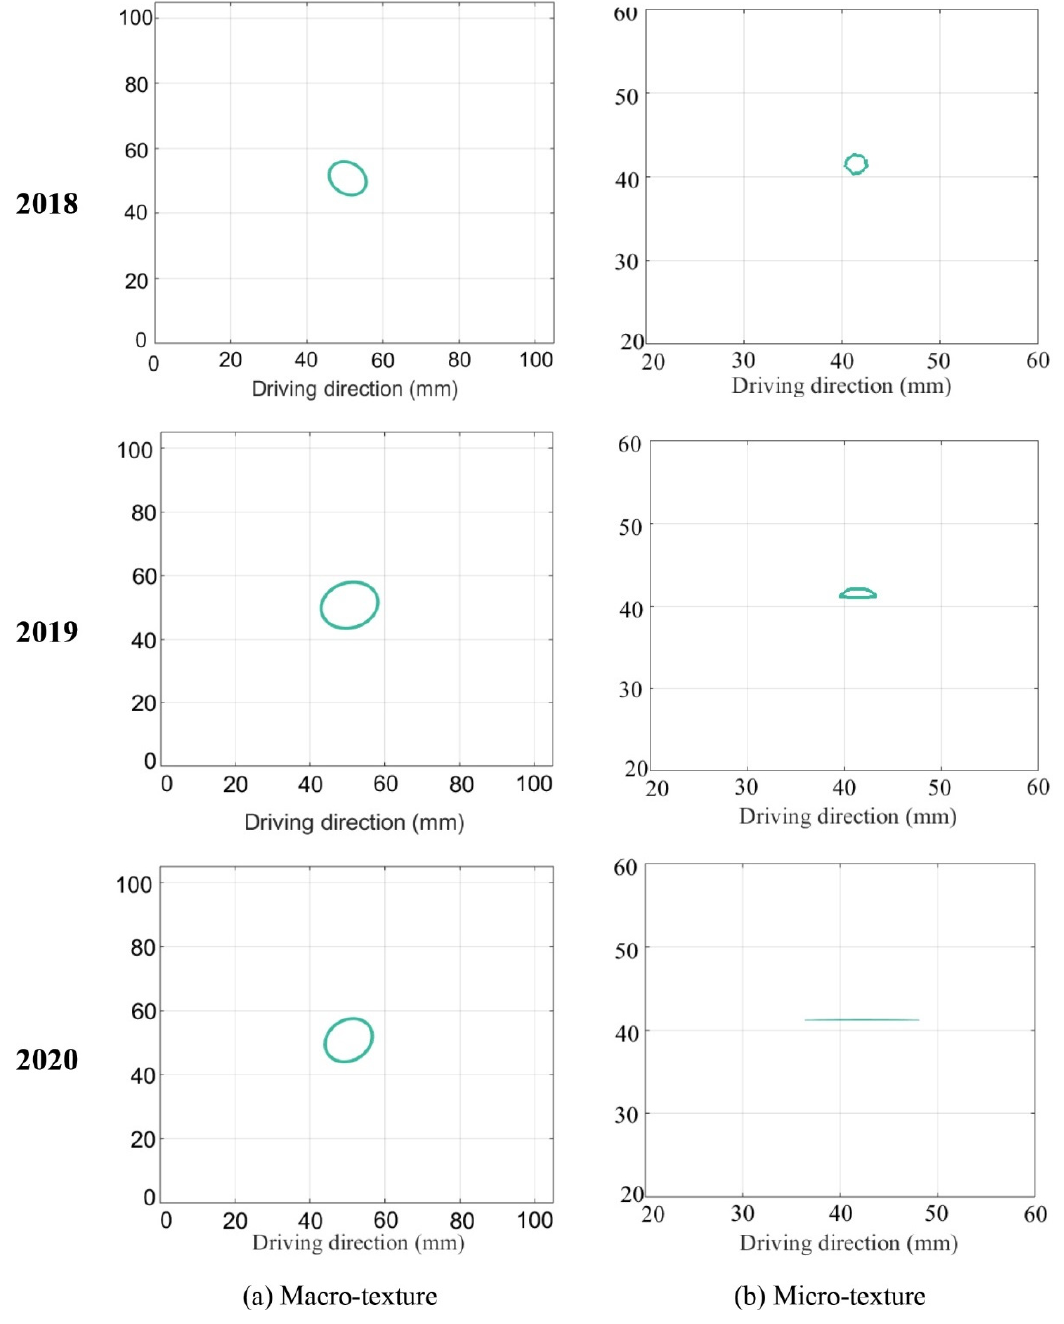
Figure 8. ACF = 0.2 for pavement macro − and micro − texture: ( a ) Macro − texture, and ( b ) Micro − texture.